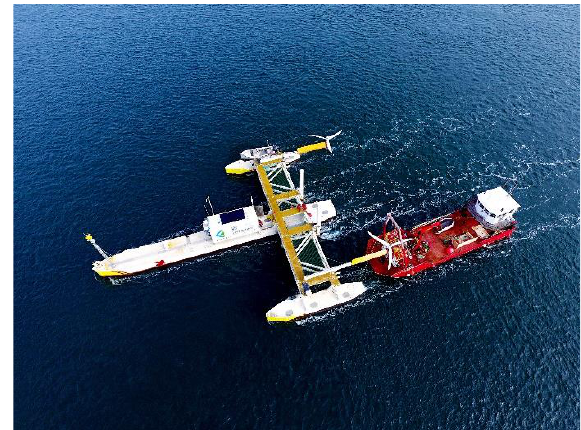
Fig. 2 Blade installation (6.3m rotors) in Grand